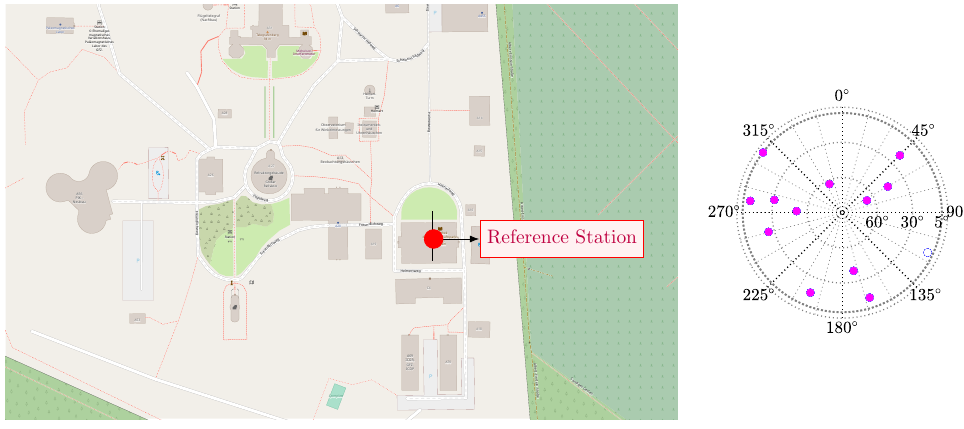
Figure 1. Right side, IGS MGEX station POTS0 in Potsdam, Germany, as reference station (red mark). Right side, skyplot of the synthetic GNSS